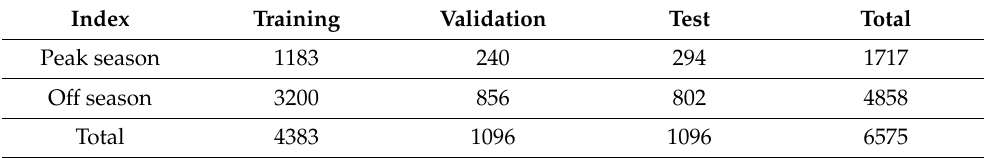
Table 1. Number of data for each dataset.